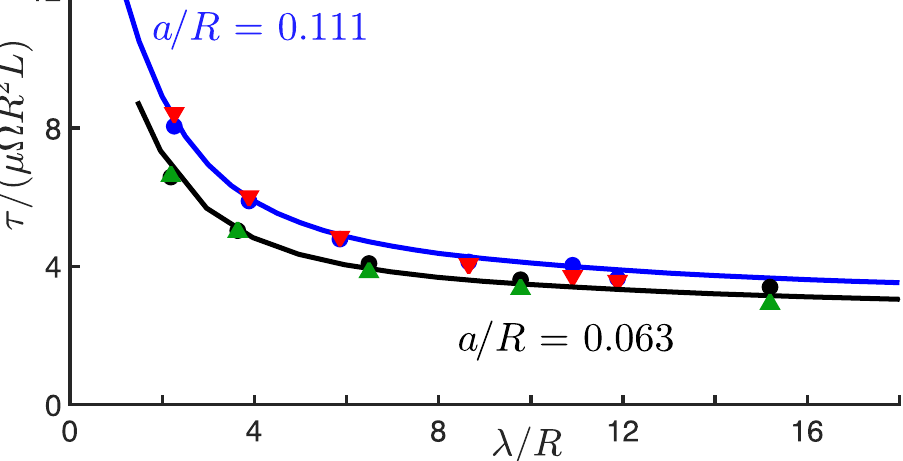
Figure 8. Dimensionless torque ( τ / ( µ Ω R 2 L ) for different flagellar wavelengths ( λ / R ), where µ is the dynamic viscosity, Ω is the angular speed, R is the helical radius, and λ is the helical wavelength. Experimental values are solid black circles and solid blue circles; our MRS simulations with a centerline distribution of regularized Stokeslets are the solid red and solid green triangles, and MRS simulations computed with a surface discretization of the helices using the code provided by Rodenborn et al. (2013) [26] are the blue and black